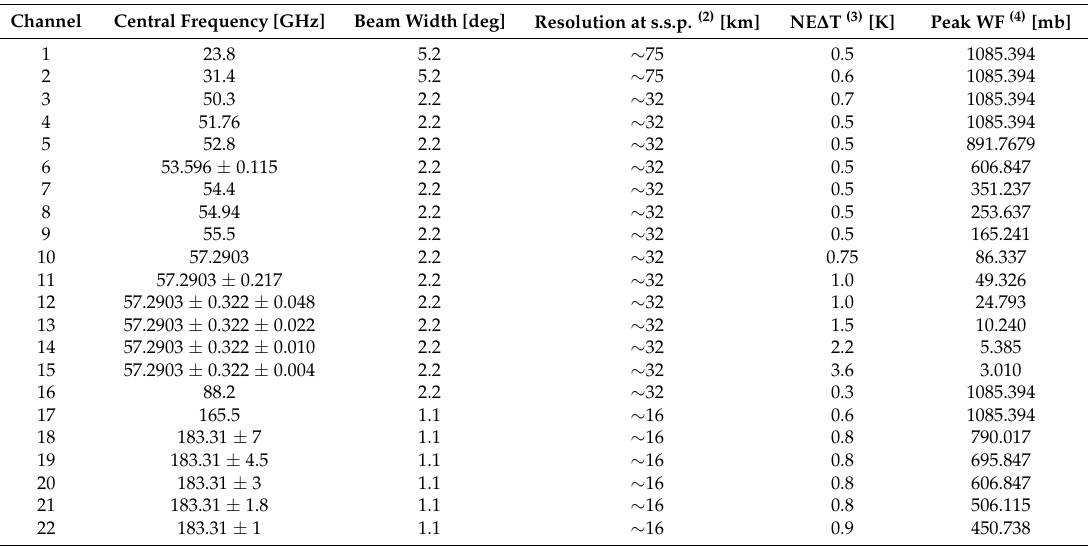
Table 1. ATMS (1) channel characteristics.